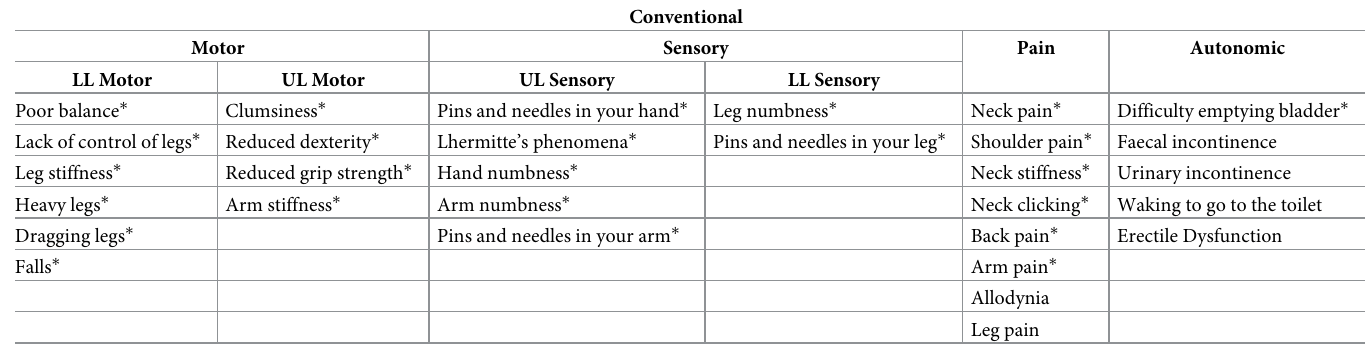
Table 1. Survey symptom classification–conventional